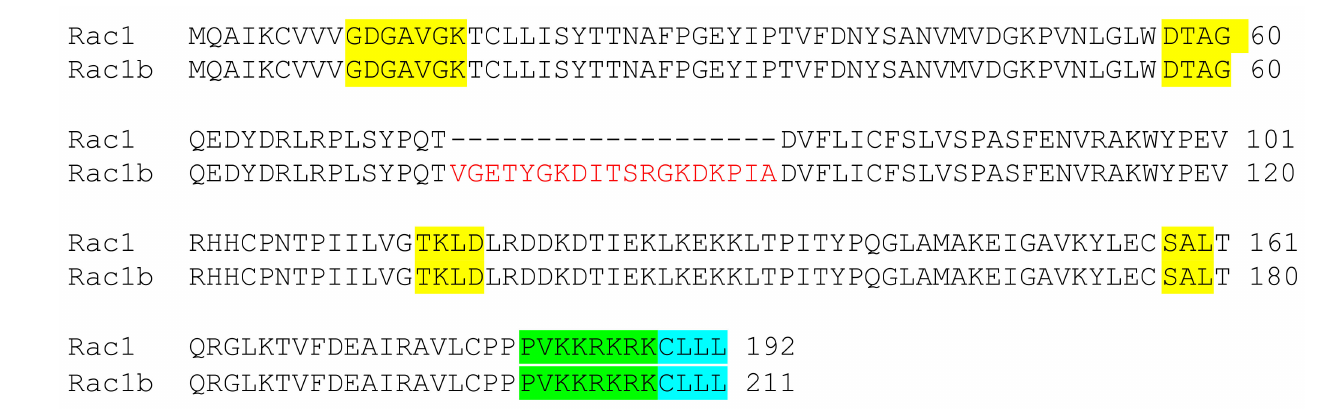
Figure 3. Splice variants Rac1 and constitutively active Rac1b differ by a 19-amino-acid insertion in Rac1b. Sequence alignments of Rac1 and alternatively spliced isoform Rac1b. GTP binding and hydrolysis domains (highlighted in yellow), GTP binding domain (yellow), hypervariable region (green), and AAX box (blue). The 19-amino-acid insertion highlighted in red leads to increased GDP/GTP exchange and impaired